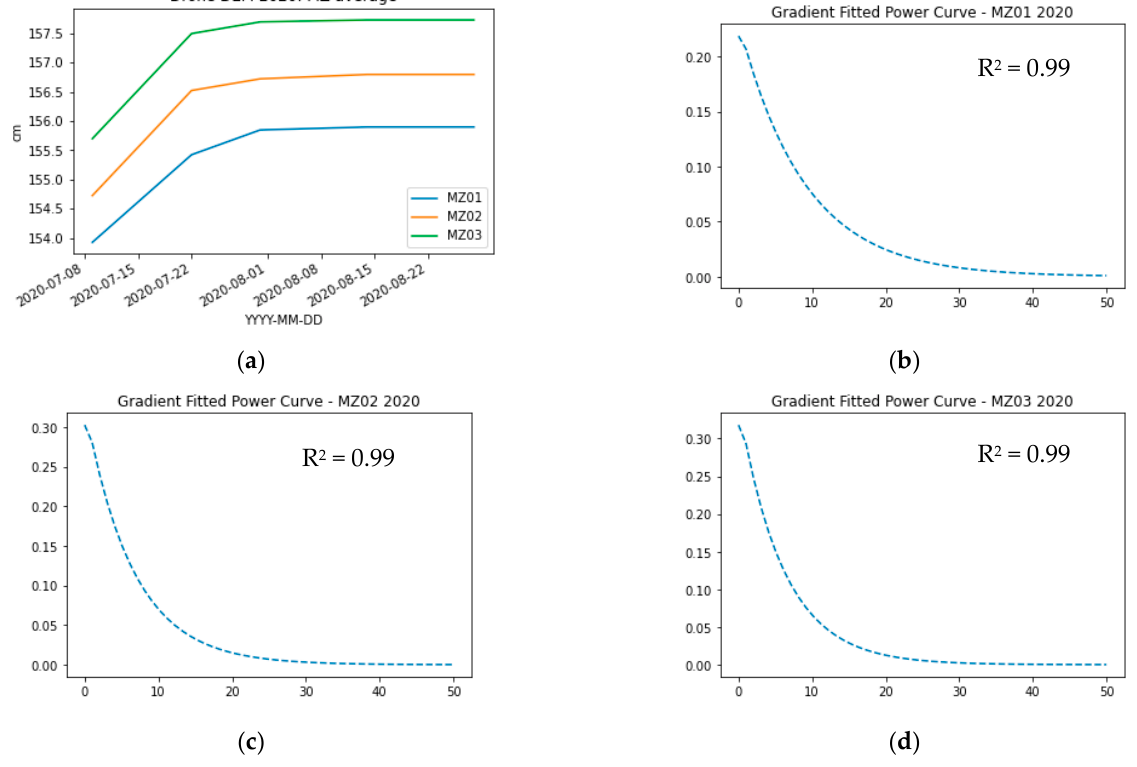
Figure 4. Evolution of plant height (H) over the 2020 growing season until H stabilization: Growth curve (( a )—cm vs date) and growth rate over management zones MZ01 ( b ), MZ02 ( c ), and MZ03 ( d ).